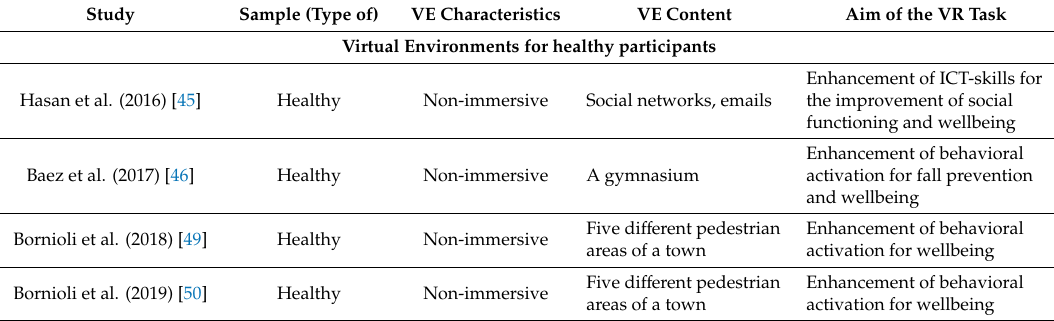
Table 5. Interventions for older